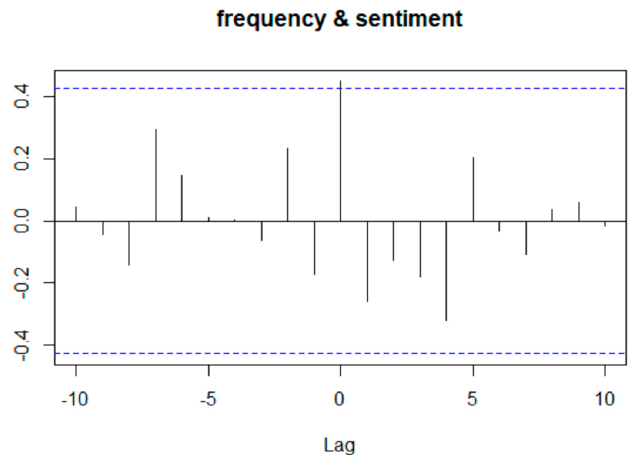
Figure 3. Auto correlation between tweet frequency and proportion of negative sentiment. Note: “Lag” on the horizontal axis refers to the number of time points that are different between A and B (in graph title). The black vertical line shows correlation between B at time x and A at time (x + lag), and the blue horizontal dash indicates the threshold of significance. If a black vertical line is taller than the blue horizontal dash, the correlation between A and B at that lag is considered statistically significant. Table 3. Number of tweets, sample tweet, and sentiment of each